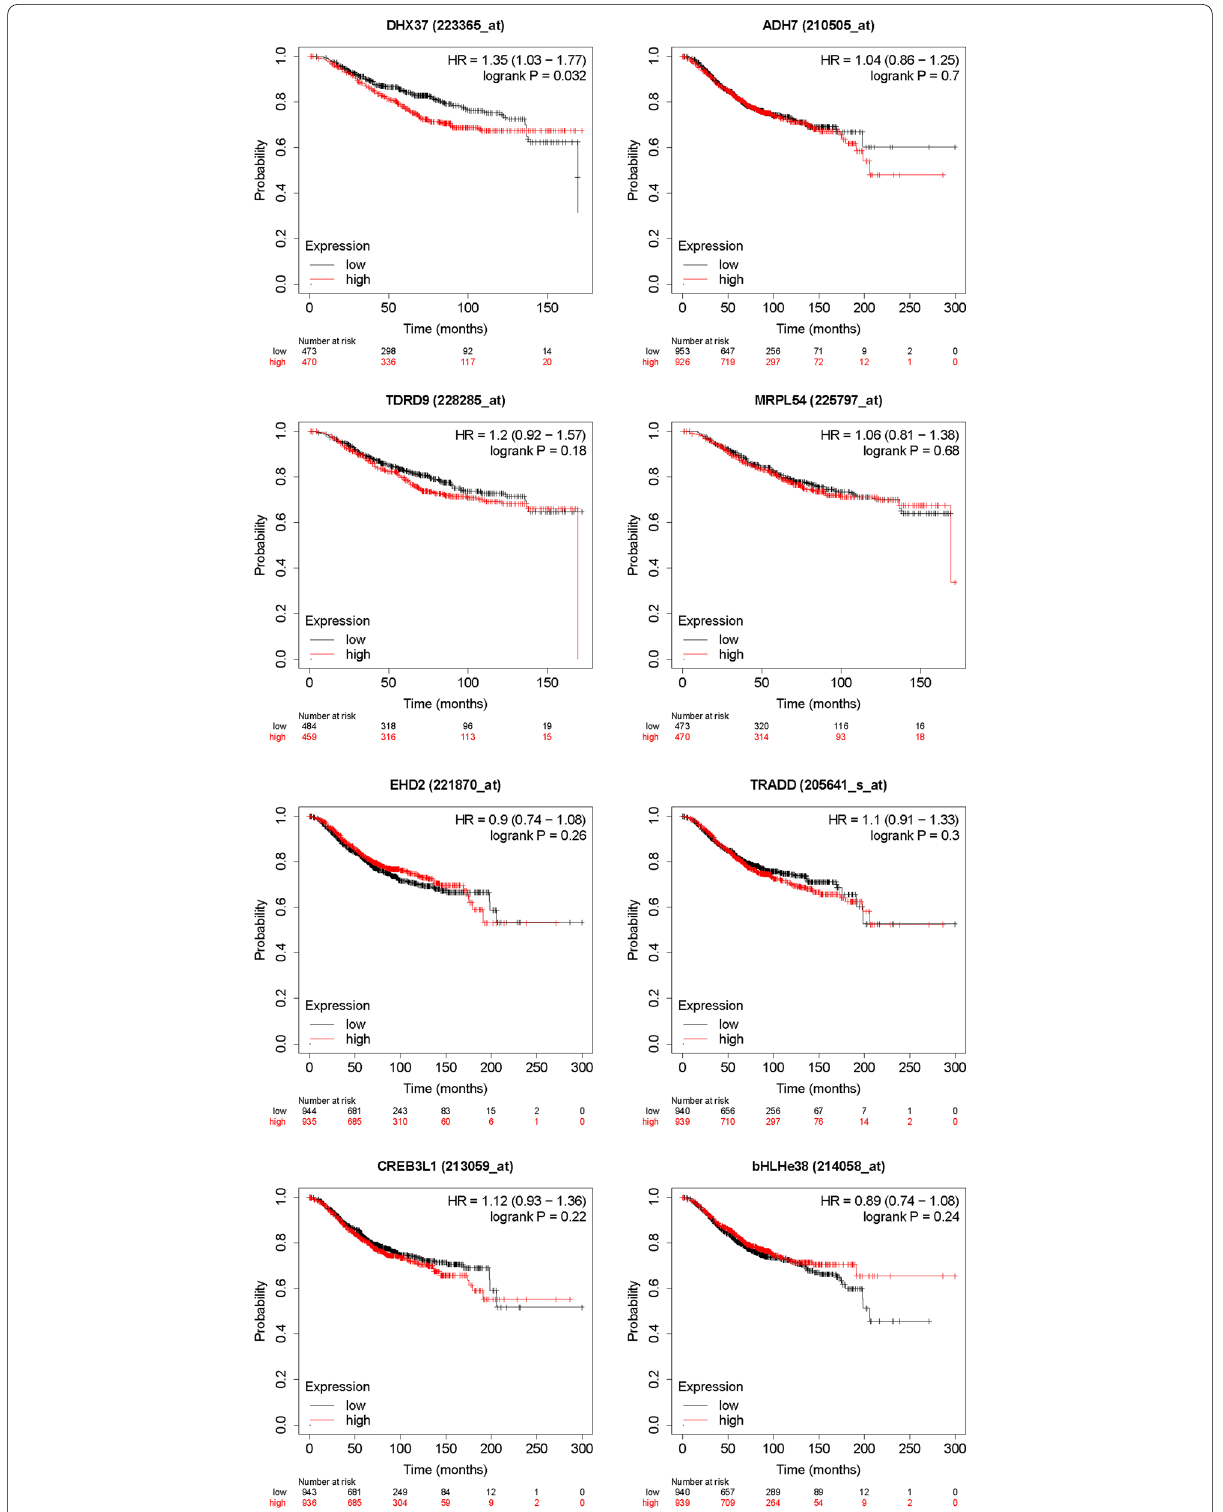
Fig. 7 The KM plot analyese for the identififed genes along with their p-value for overall survival rate (note: the other name for AACT is SERPINA3 as listed in the figure and no OS data were available for OR2G2 and C5orf52